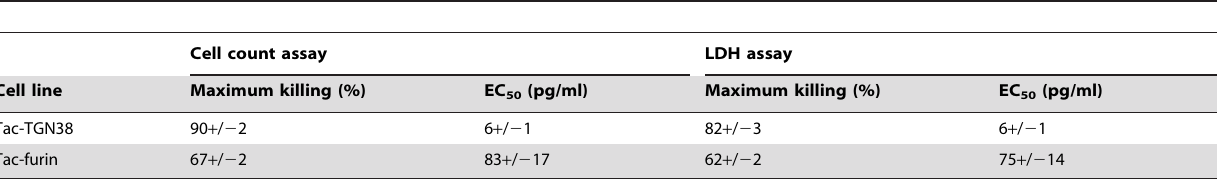
Table 1. The data in Figure 2 were fit in SigmaPlot using a four parameter logistic model (Hill-Slope model) with the equation y=y 0 + (a/(1 + (x/x 0 ) b )) where b = slope, y =concentration, x 0 =EC 50 and a= maximum response [26,27,28,38].